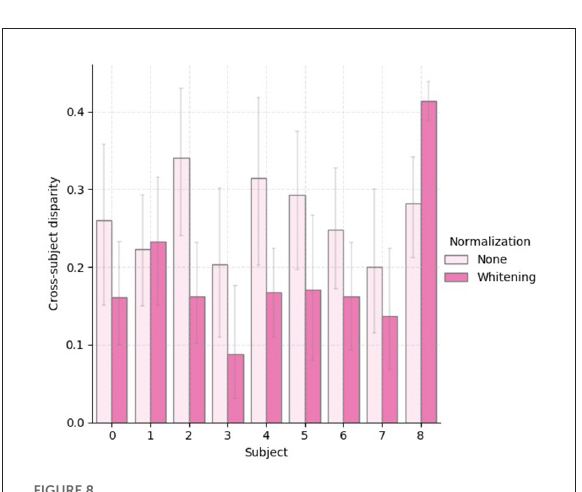
FIGURE8 Bar plot with the average cross-subject disparity for 30 independent estimates of the disparity matrix for the subjects that performed the experiment using a treadmill